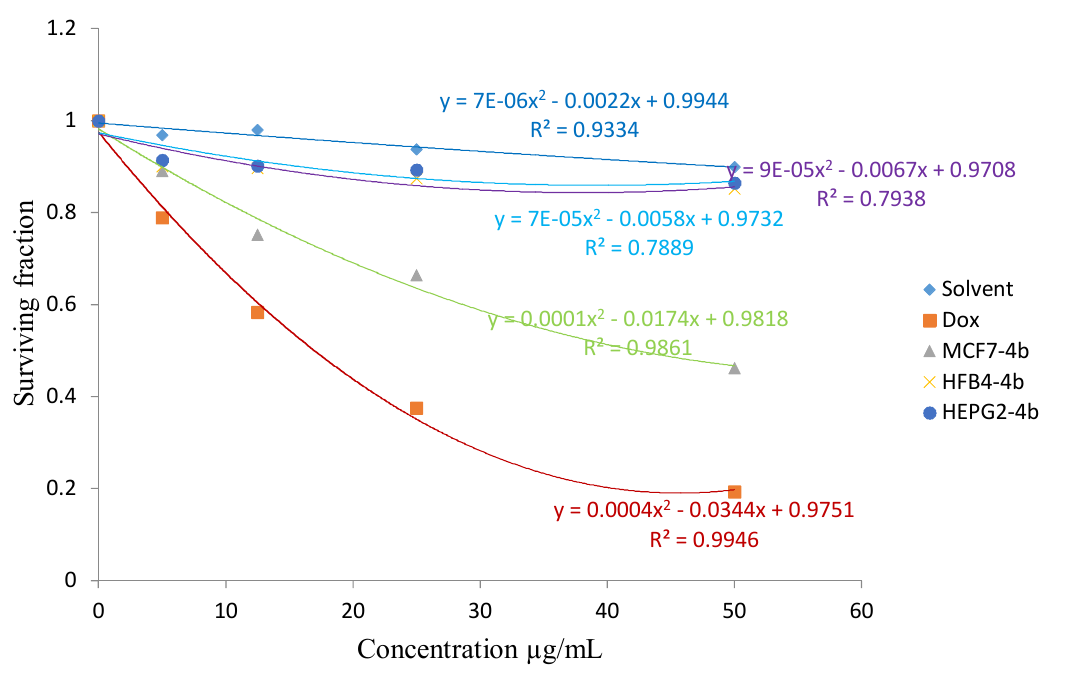
Figure 1. The cytotoxic activity of the synthesized product 4b against breast MCF7 cancer cell line.